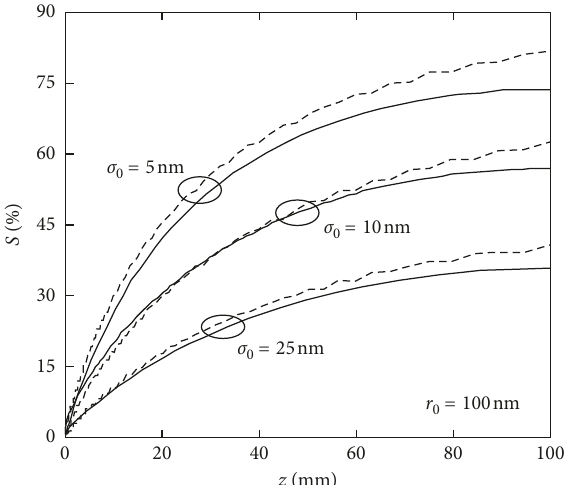
Figure 16: Simulation results using the continuous approach (solid lines) and discrete approach (dashed lines) for an infinite plate with a thickness of 200mm: saturation profiles at the end of the first drying